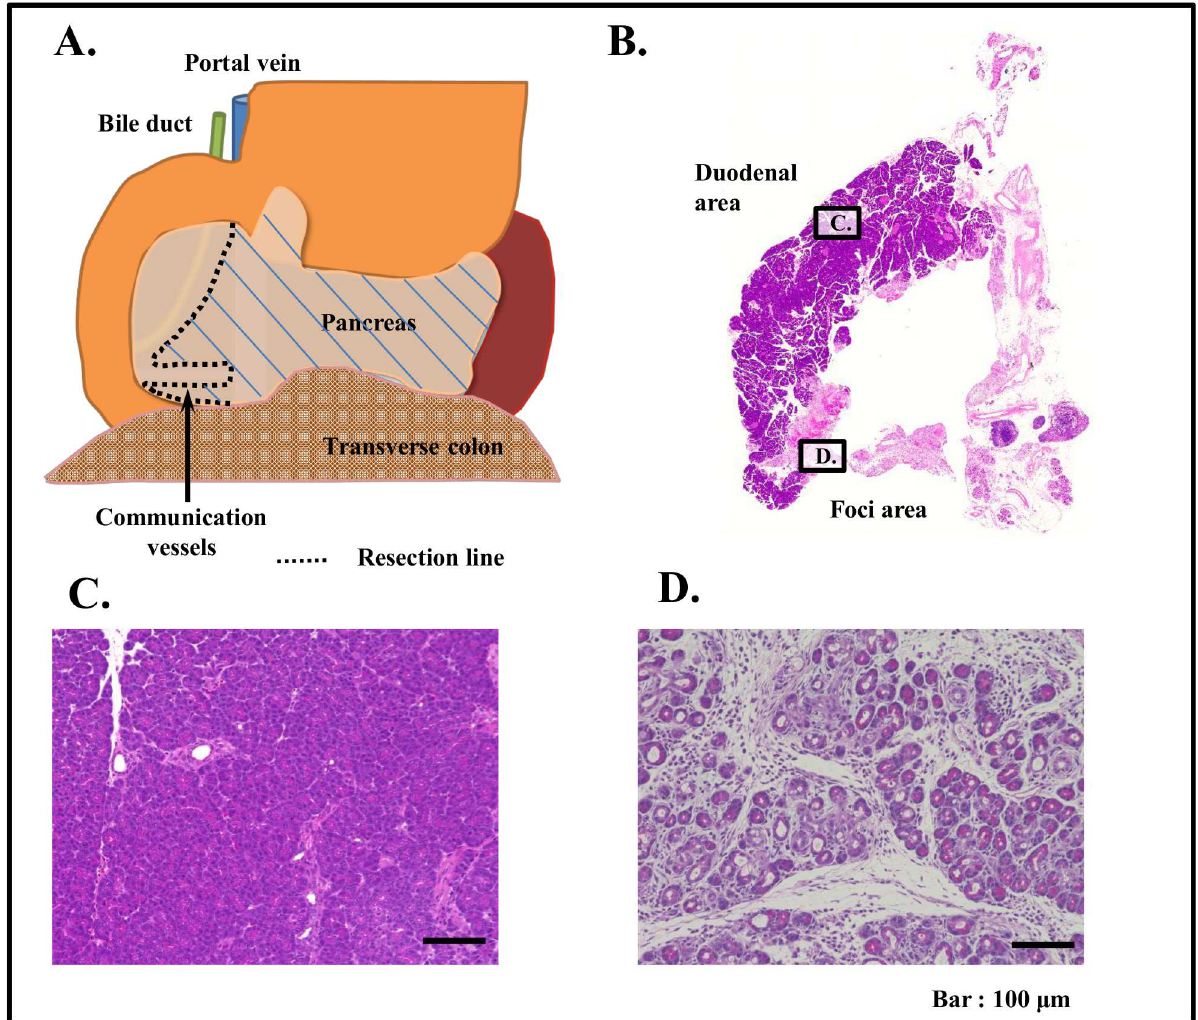
Fig 1. Schematic drawing of PX procedure, and gross appearanceand histological feature of remnant pancreas. (A) Schematic drawingof remnant pancreas of 90% PX (rat). 5 rats were used for this experiment. Gross and histological appearances of these 5 rats were essentiallythe same. Thus representative gross appearanceof remnant pancreasfrom 90% PX rat is shown in (B). (C)(D) Representative histological images of HE stainedtissue specimenof duodenal area (C) and foci (D) of remnant pancreas from 90% PX rat. Note totally distinct histological feature of C from